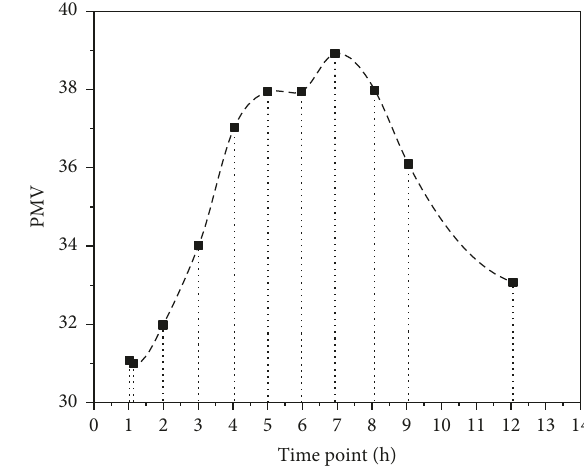
Figure 7: Temperature forecast for the